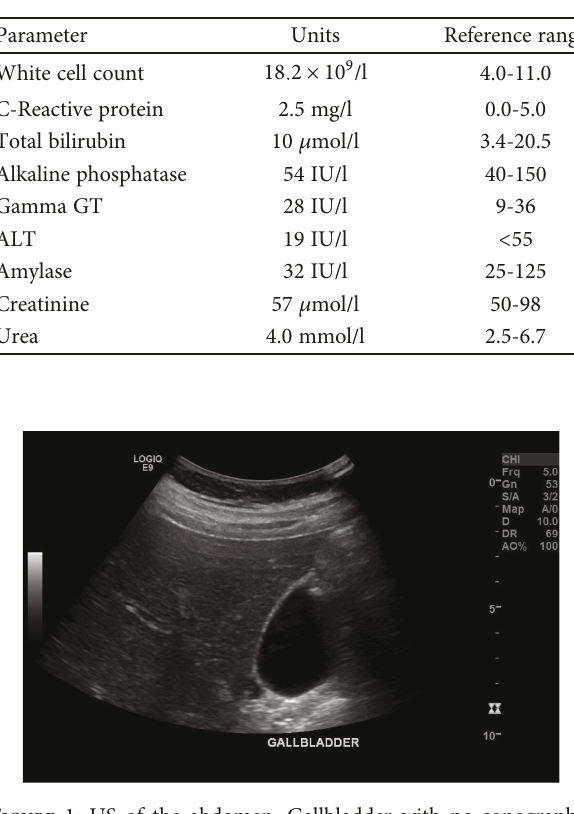
Table 1: Blood test results in the emergency department.